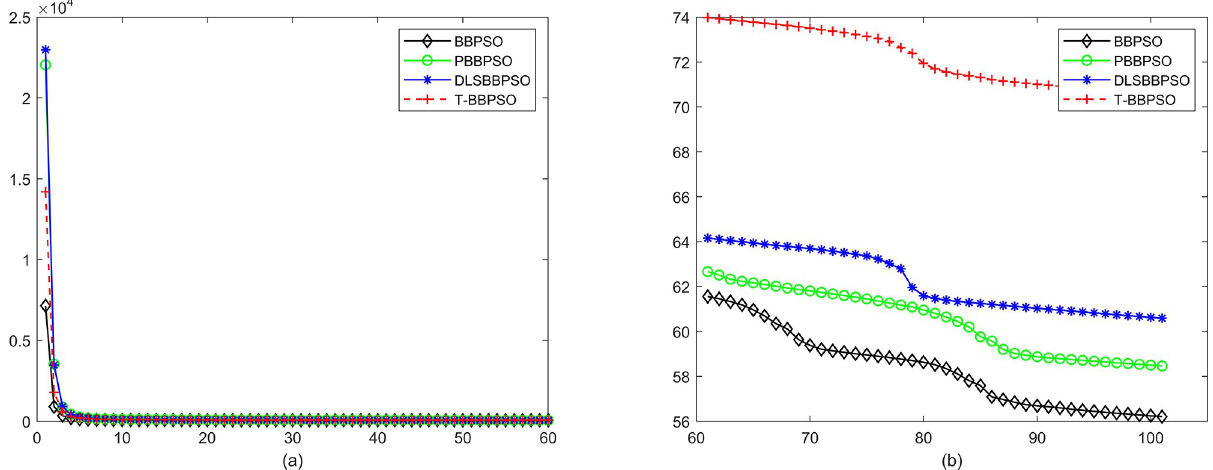
Fig 6. Comparison of convergence speed between BBPSO, PBBPSO, DLS-BBPSO and TBBPSO, f 4 , (a) iteration 0–6000, (b) iteration 6000–10000 the unit is 100 iteration.